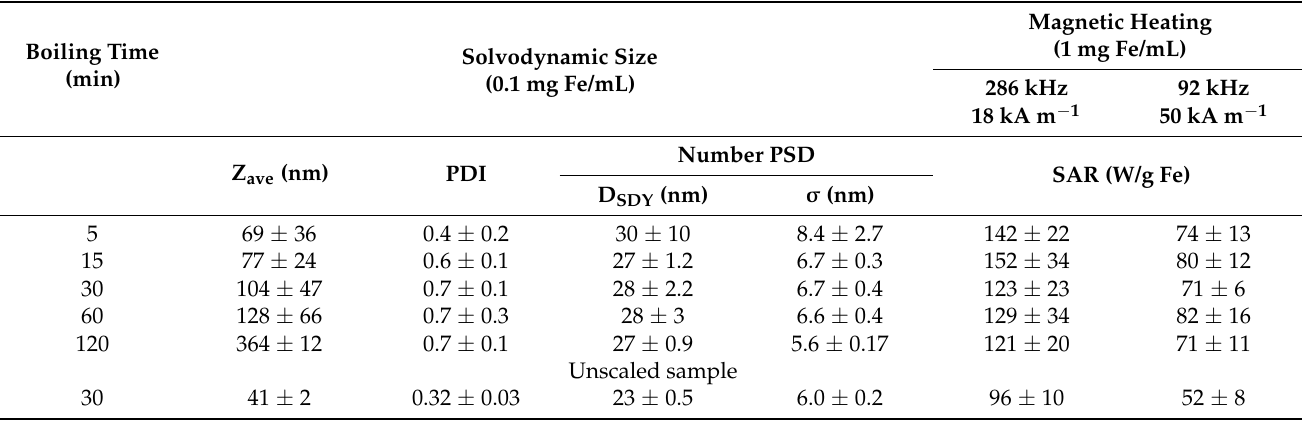
Table 2. Solvodynamic size average values and SAR at different field conditions measured in nanoparticle suspensions of oleic acid:toluene 1:7 v / v .